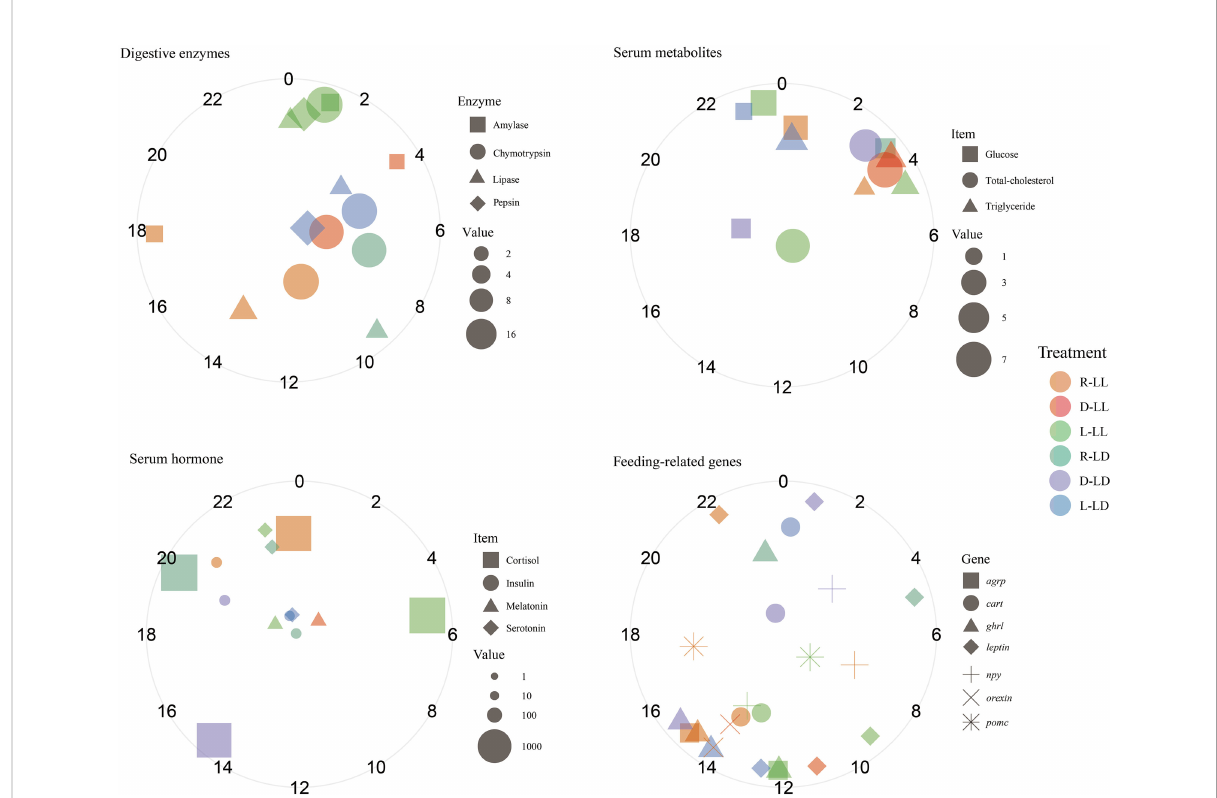
FIGURE 6 The peak time of the indicator with diurnal oscillation in this study. The distance from the center of the clock indicates signi fi cance, with closer to the edge of the clock indicating stronger rhythmic oscillations (smaller P